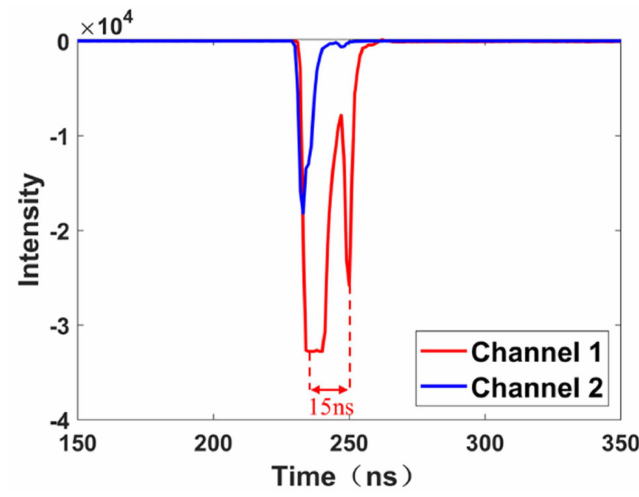
Figure 29. Waveform under the reservoir experimental environment.